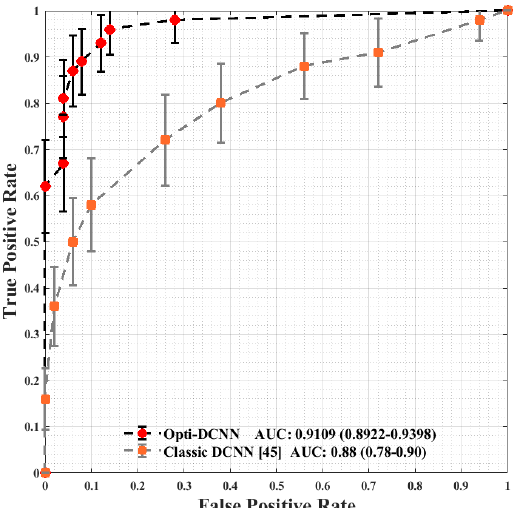
Figure 10. TPR curves for OptiDCNN and classic DCNN. The bars indicate the range of the ten runs performed.